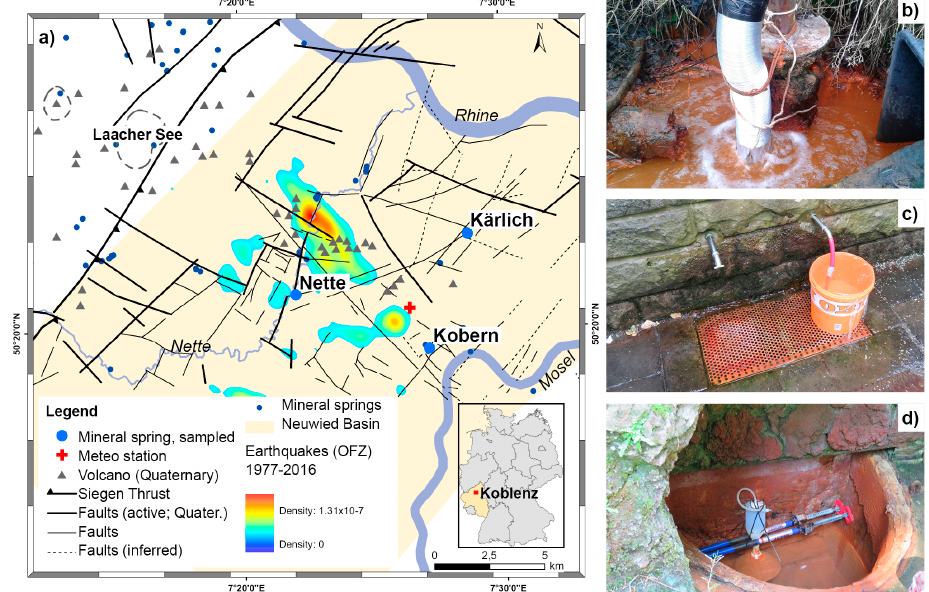
Figure 1. The three studied mineral springs (MS; light blue dots) ≈ 15 km SE of the Laacher See volcano within the Neuwied Basin (NWB, light yellow area); the inset shows the location of the study site within Germany. The map ( a ) shows tectonic structures (black lines) and active faults (bold black lines according to [42]) compiled from the literature and different tectonic maps (e.g., [49]), additional mineral springs (dark blue dots), Quaternary volcanoes (grey triangles), location of the meteorological station at the Goloring site (red cross), and probability density of the earthquake events from 1977–2016 that were related to the Ochtendunger Fault Zone (OFZ; rainbow contours; based on data provided in earthquake data catalogues [50,51]). River names are written in italics. CO 2 , He, and Rn were sampled from the mineral springs. Photographs show ( b ) Nette and ( c ) Kärlich with modified outlets, and ( d ) Kobern equipped with a permanent gas mouse (all photographs: G.M.